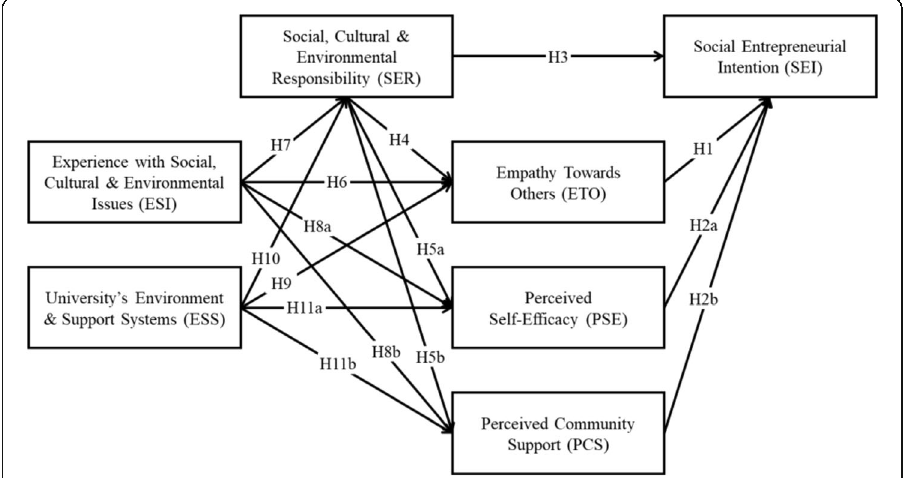
Fig. 1 Conceptual model of social entrepreneurial